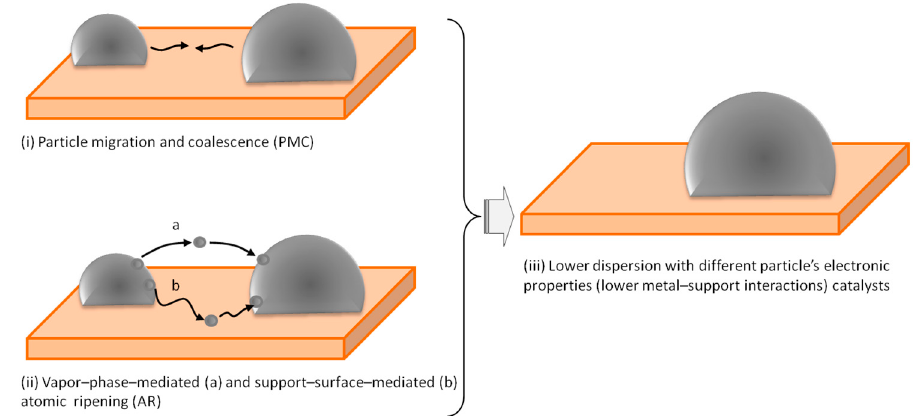
Figure 1. Schematic of potential sintering mechanisms of catalytic nanoparticles leading to sintering, fewer undercoordinated sites and reduced metal–support interaction.